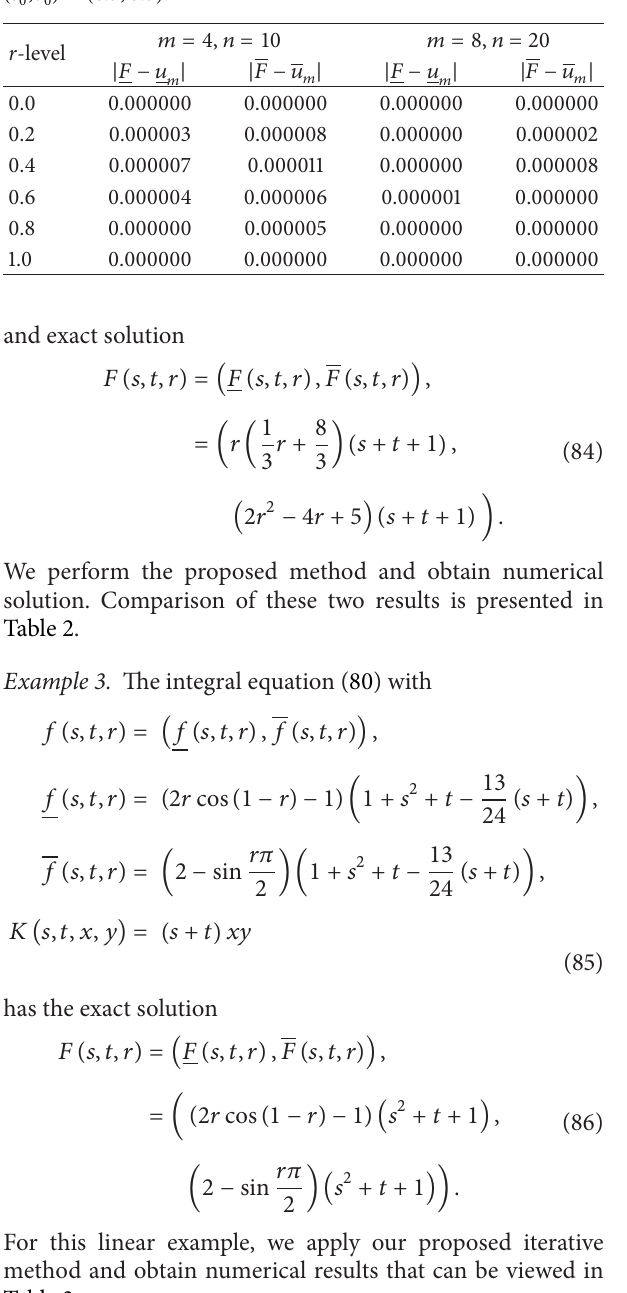
Table 3: Numerical results on the level sets for Example 3 in